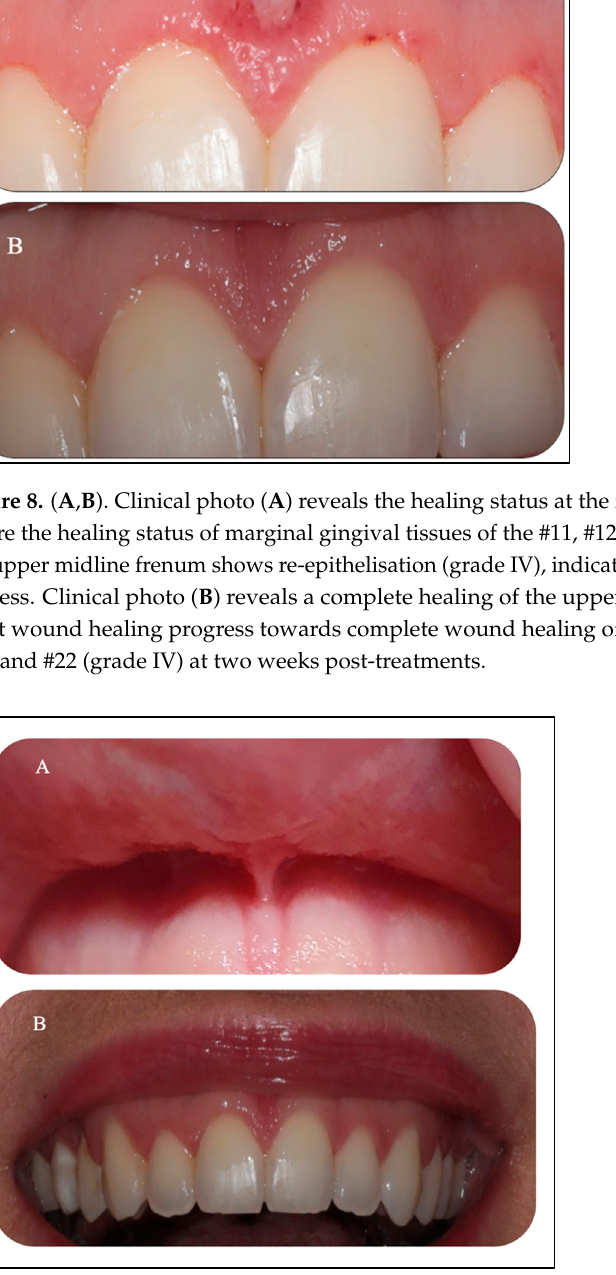
(green line) of #12 and #22 gingival margins. The photos highlight the clinical